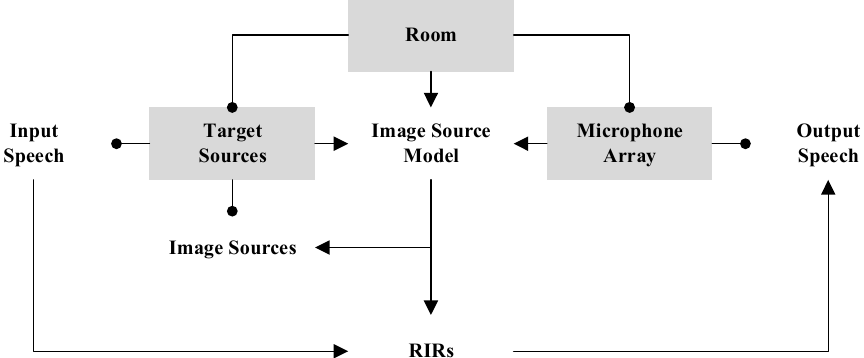
Figure 1. The block diagram of the pyroomacoustics . The lines terminated by a bullet indicate attribute relationship and arrows indicates parameters to functions.